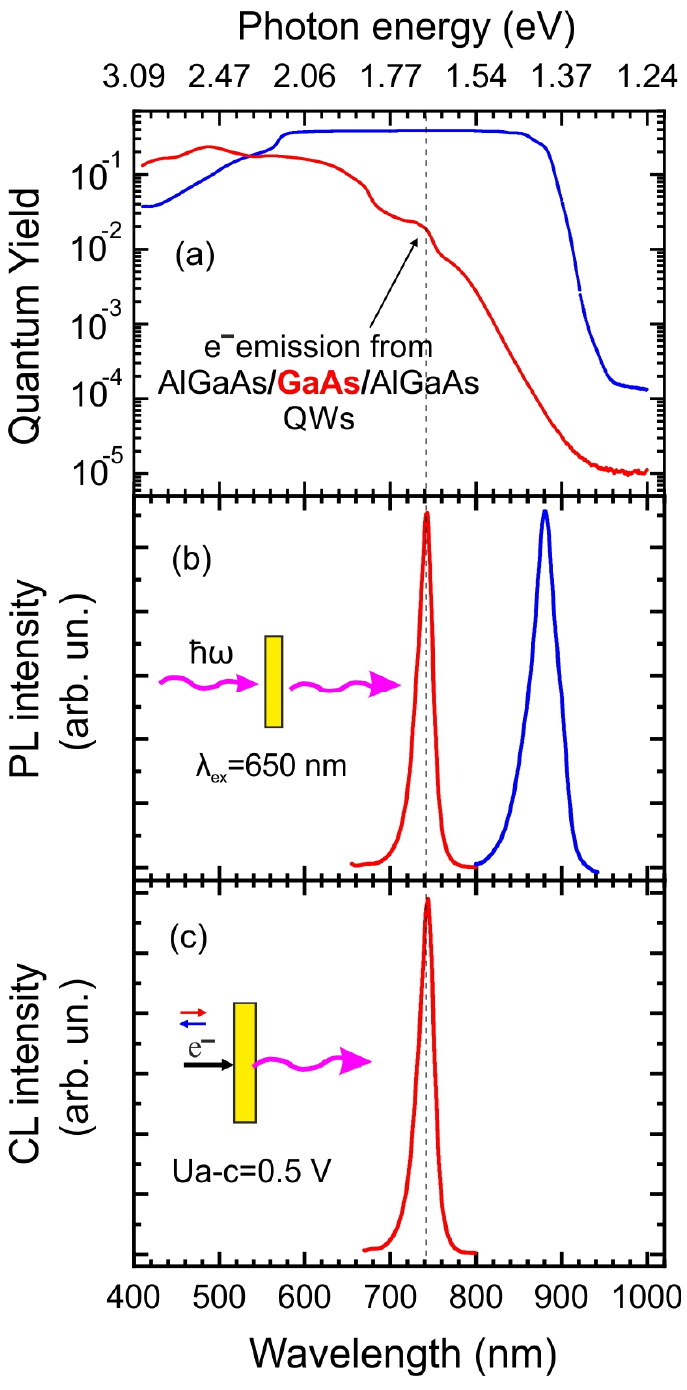
Figure 3. ( a ) Quantum yield (QY) spectra of GaAs photocathode (blue) and Al x Ga 1 − x As/GaAs QWs target (red). The QY spectra were measured by applying of 1 V to the emission electrode. The arrow denotes the feature corresponding to the electron emission from quantum-dimensional (QD) levels. ( b ) Photoluminescence spectra from GaAs photocathode (blue) and Al x Ga 1 − x As/GaAs QWs target (red). ( c ) Cathodoluminescence spectrum of an Al x Ga 1 − x As/GaAs QWs target excited by injection of electrons photoemitted from the photocathode at an accelerating voltage of 0.5 V. The peak positions in the photoemission spectra ( a ), PL ( b ) and CL ( c ) have the same energy and comply with the calculated QD levels in QWs.